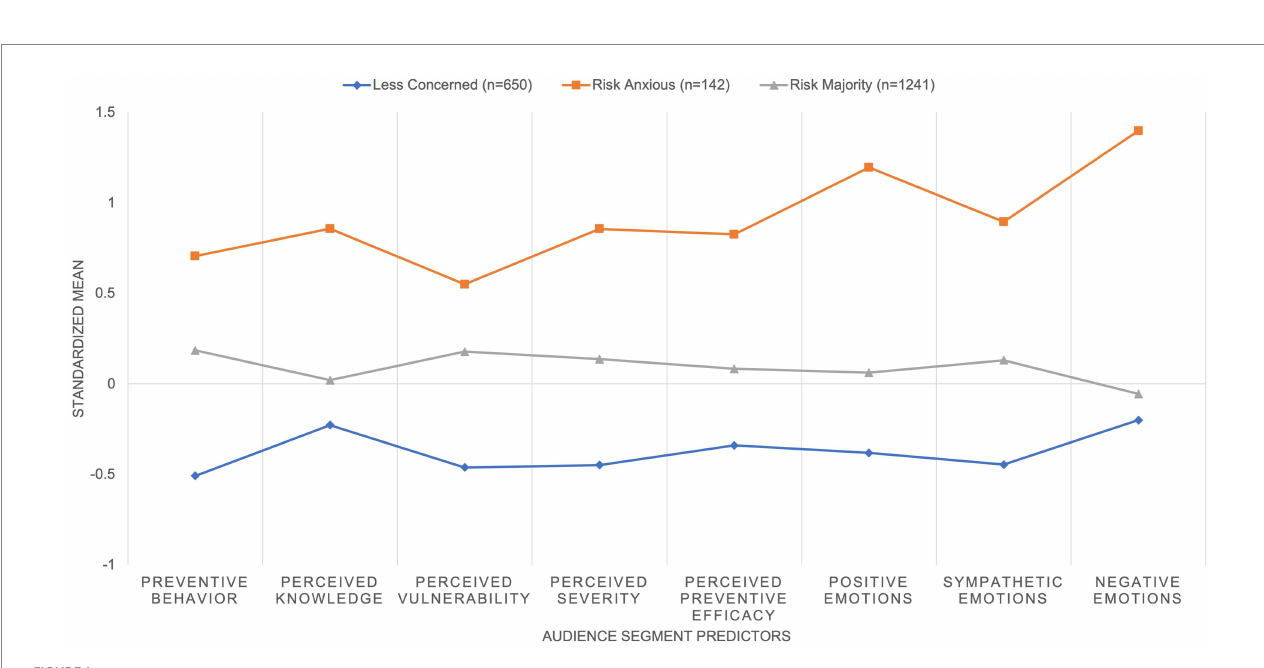
FIGURE 1 3-class solution from LPA on audience